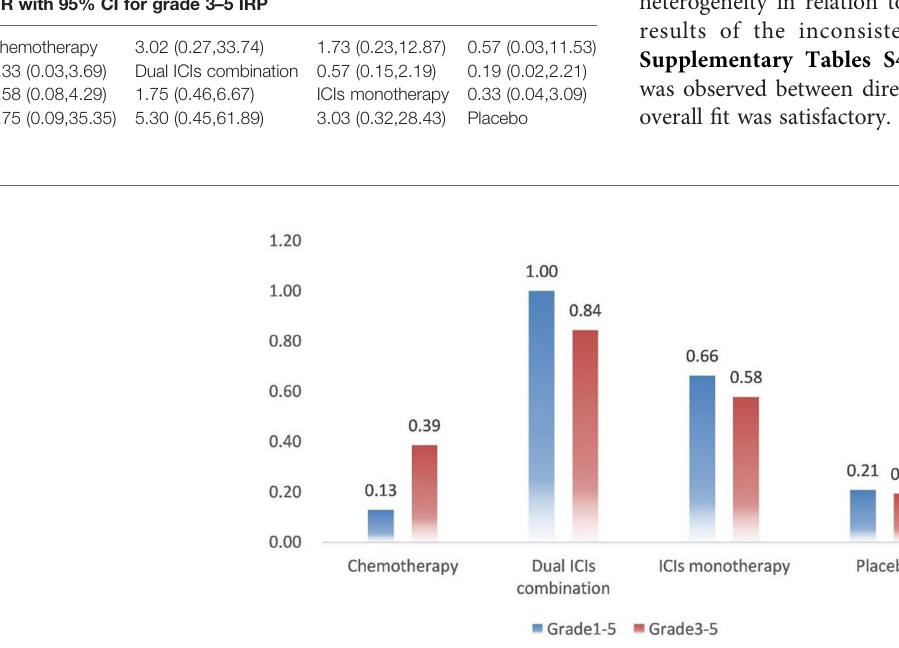
TABLE 3 | Multiple treatment comparison for IRP based on network consistency model (for grade 3 – 5 IRP). OR with 95% CI for grade 3 – 5 IRP Chemotherapy 3.02 (0.27,33.74)